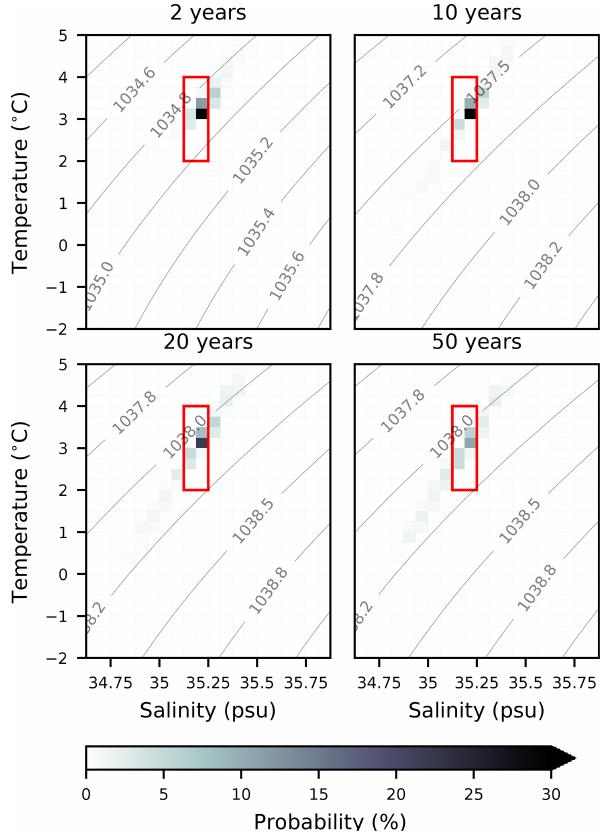
Figure 12. As in Fig. 7 but for subpolar-outcropping model NADW at 2, 10, 20, and 50 years. Note that the region enclosed by the red box is the same in both subpolar- and Arctic-outcropping (Fig. 16) cases.